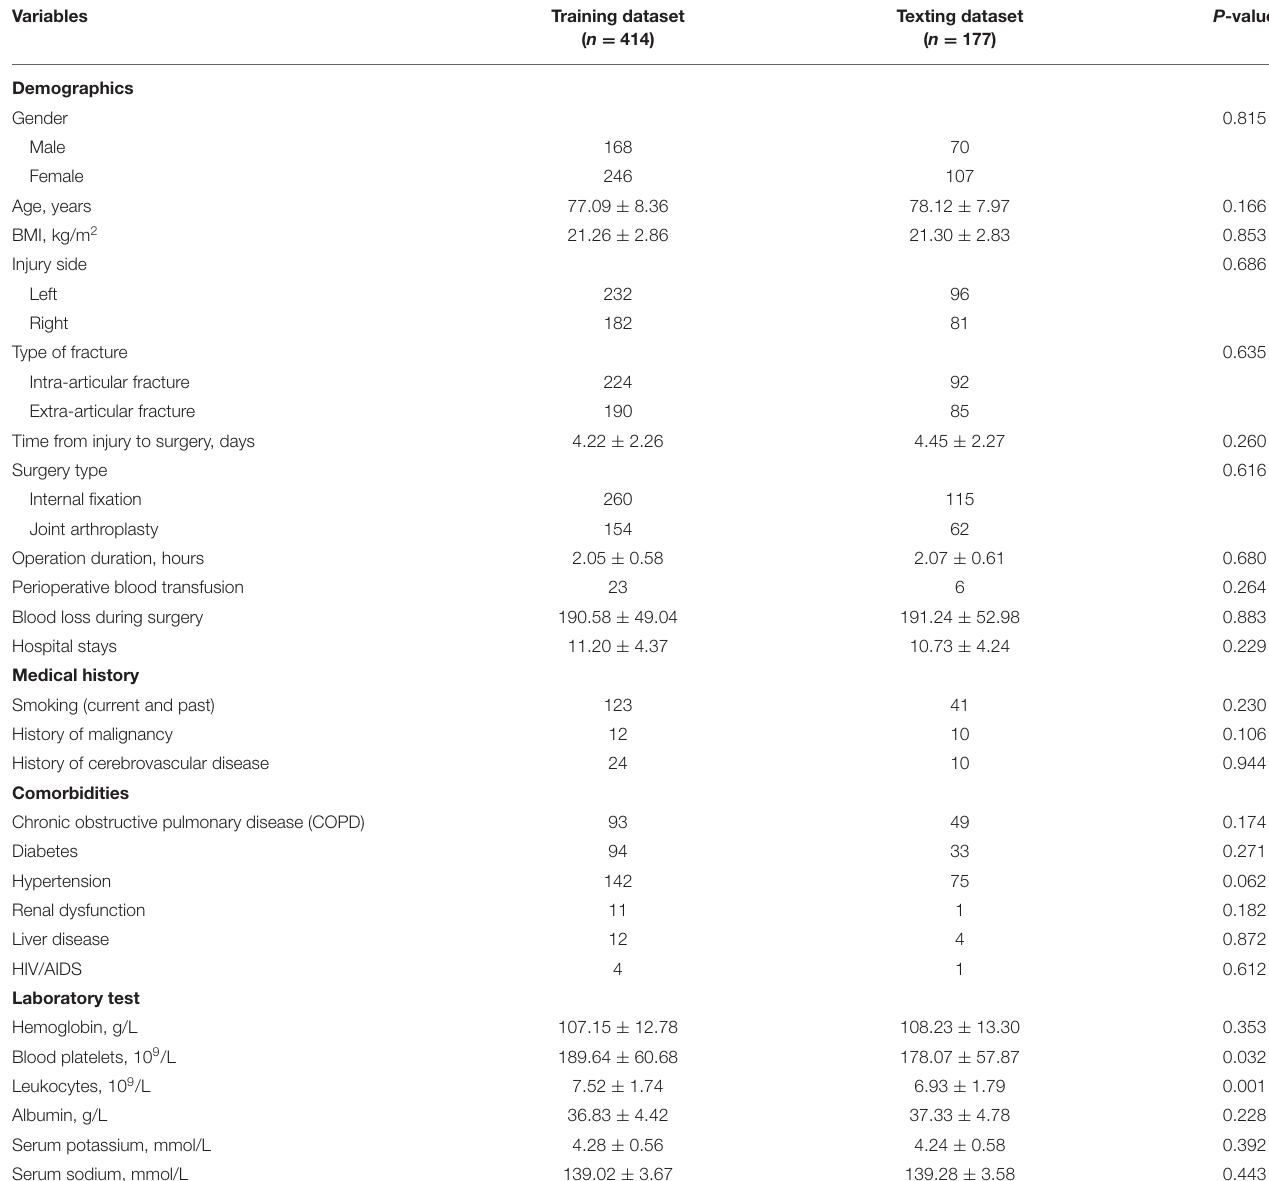
TABLE 2 | The baseline characteristics of training dataset and texting dataset. Variables